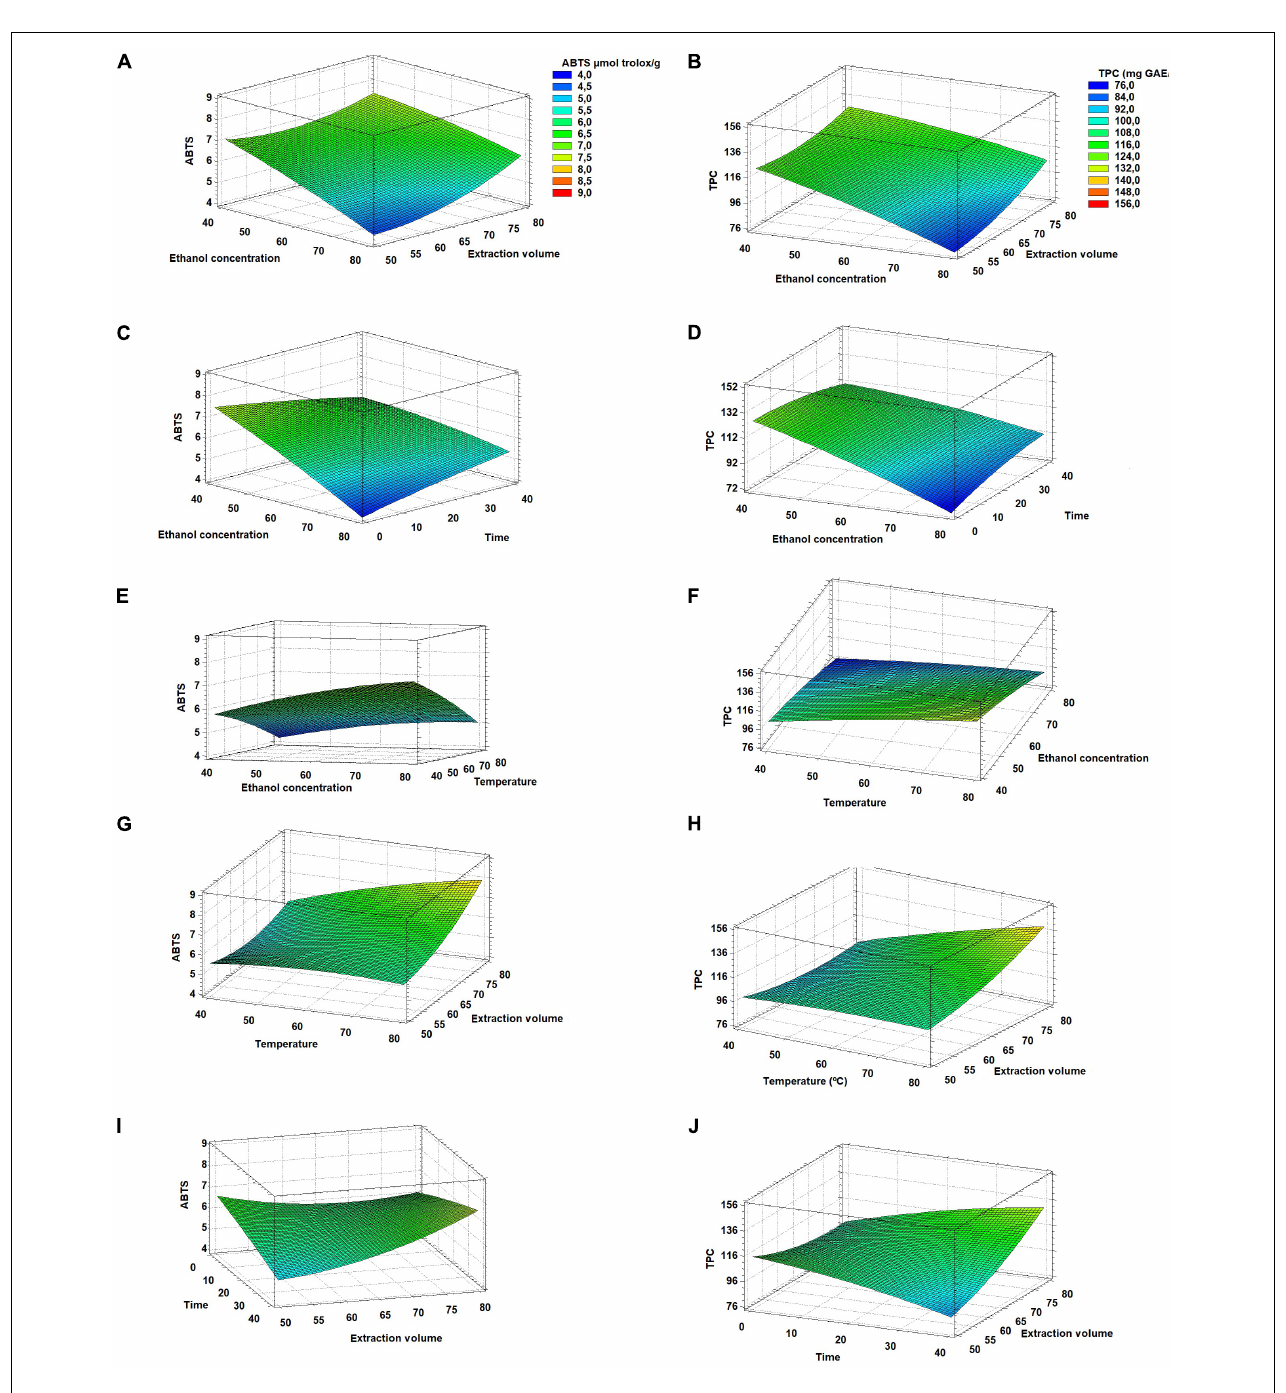
FIGURE 4 | (A–J) Response surface plots showing significant interactions between independent variables on ABTS (left column) and TPC (right column).